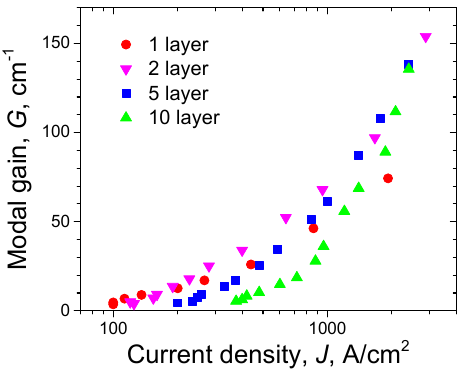
Figure 12. The dependences of modal gain on the injection current density for devices with different numbers of QWD layers.